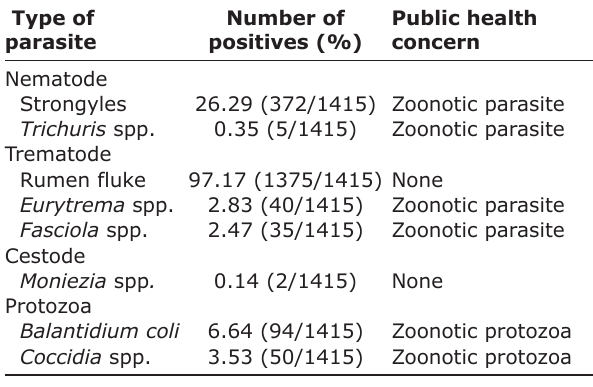
Table-1: The gastrointestinal parasites found in 1415 positive samples of fighting bulls.